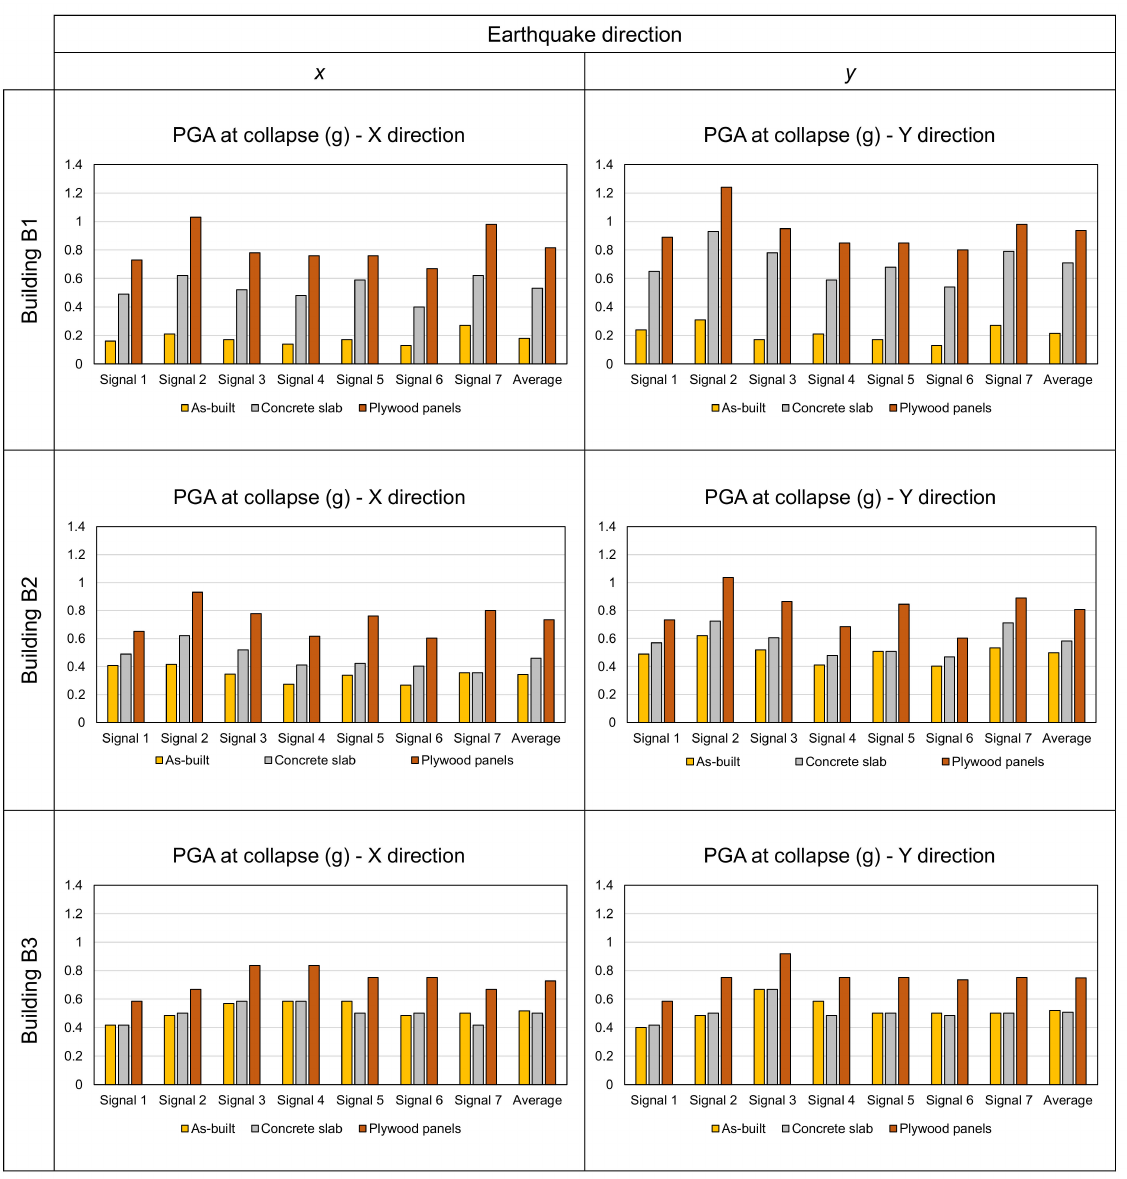
Figure 11. PGA at collapse, displayed for each signal and on average, recorded for the three case–study buildings. Starting from building B1, it can be noticed that as-built configuration B1-AB already collapsed at a low level of intensity (average PGA = 0.18 g in the weakest loading direction) due to the out-of-plane failure of (portion of) walls or gables. On the contrary, with floors stiffened with a concrete slab (configuration B1-RC), a great improvement in the capacity of the building was obtained (average PGA = 0.53 g in the weakest direction), mainly because of the enhanced box behavior, leading to the in-plane collapse of masonry walls. Yet, the best performance was retrieved with the plywood panel overlay in both loading directions (configuration B1-PP, average PGA = 0.81 g in the weakest direction); the box